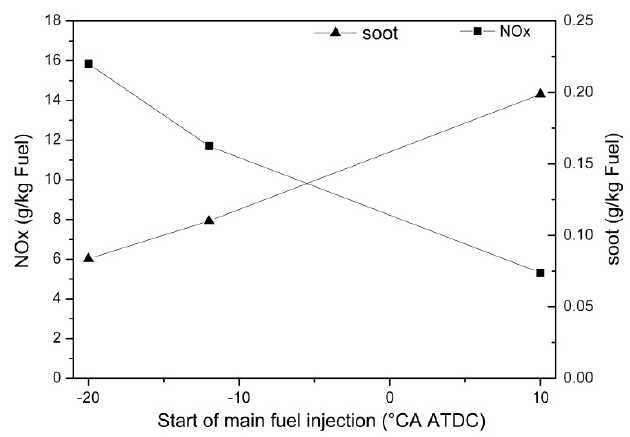
Figure 14. Comparisons of NO x and soot emissions under the cases of assigned EGR stratification with different start time of main fuel injection.